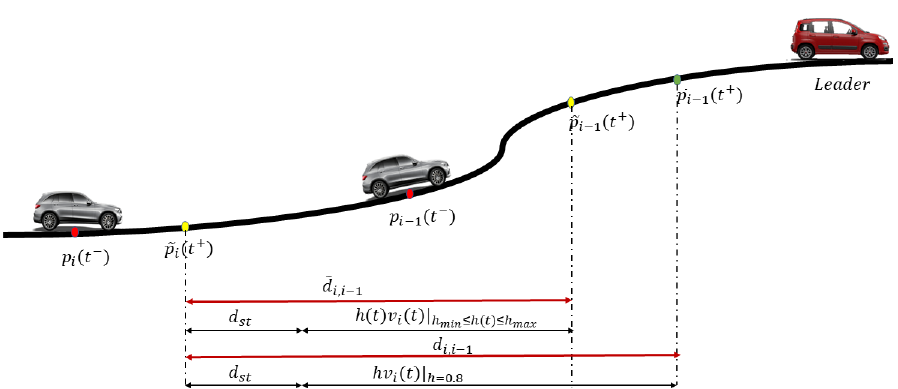
Figure 2. Energy-oriented optimal spacing policy for the EV i